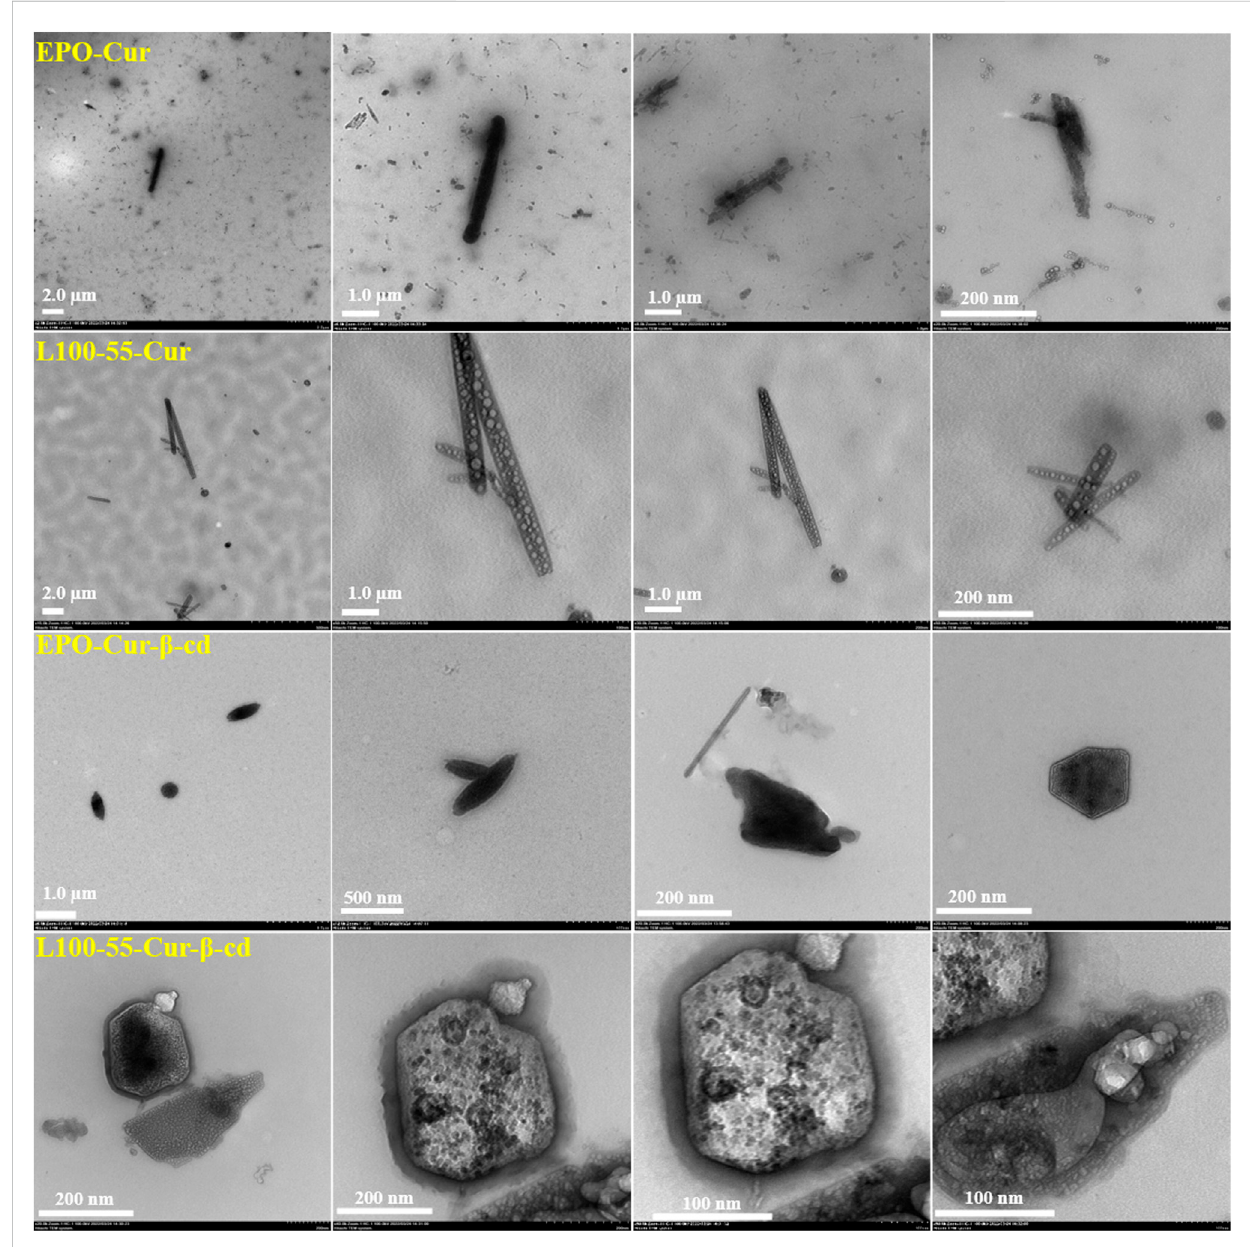
FIGURE 5 Transmission electron microscope images of complexes L100-55-Cur, L100-55-Cur- β -cd, EPO-Cur and EPO-Cur- β